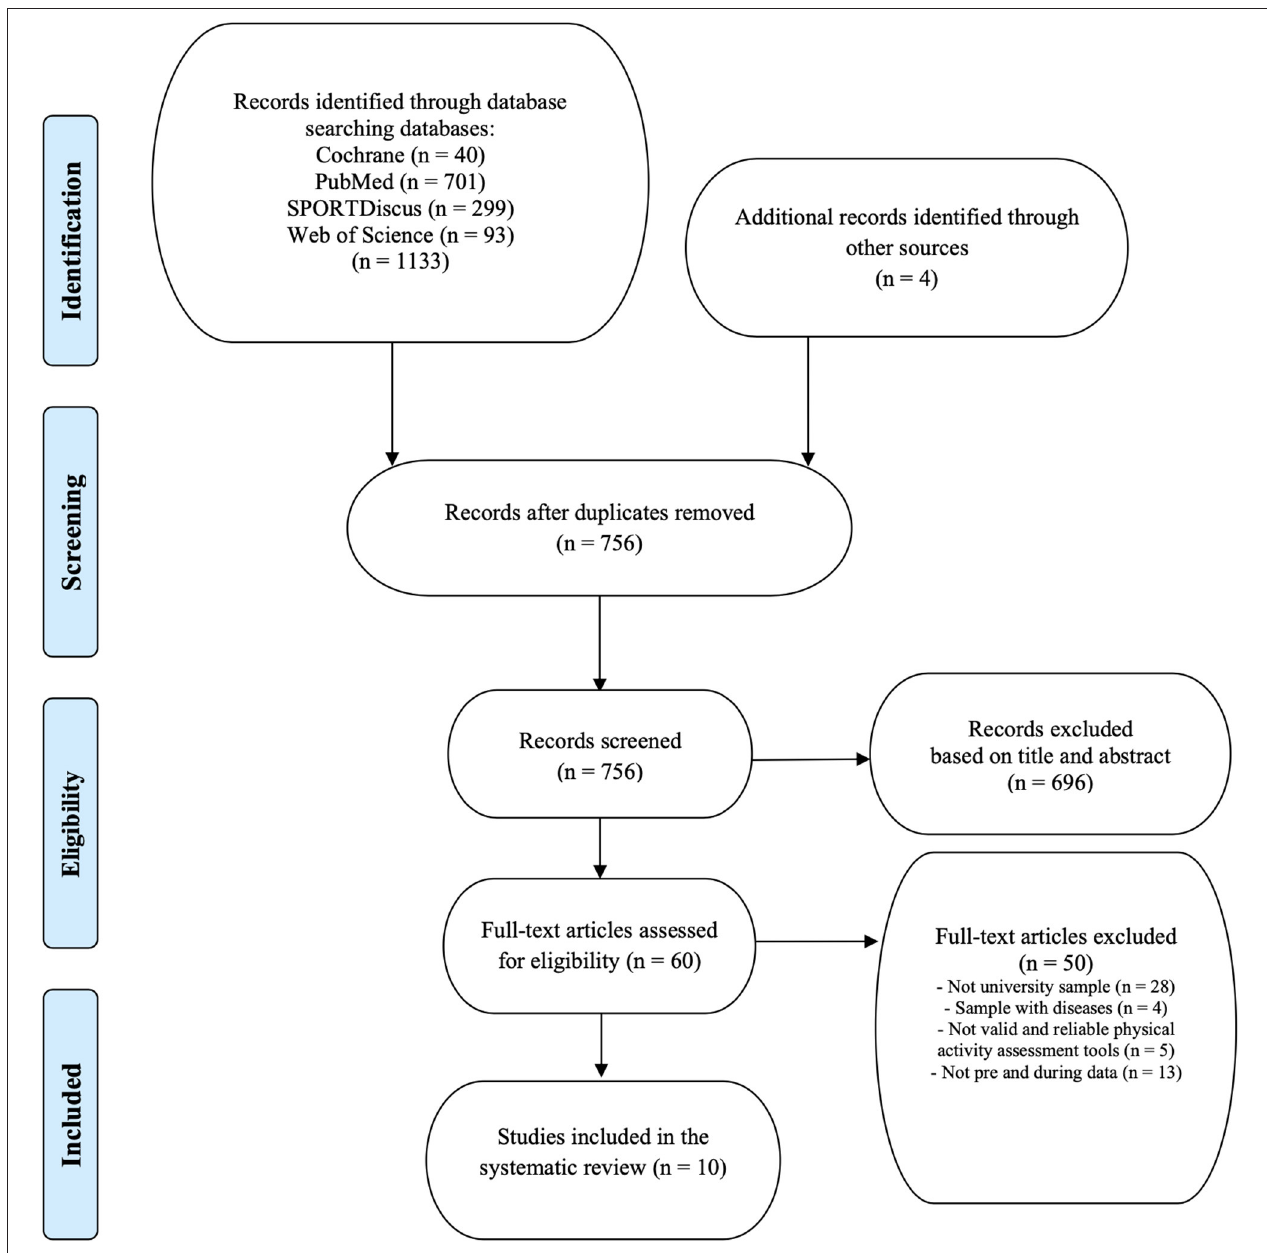
FIGURE 1 | Systematic literature review